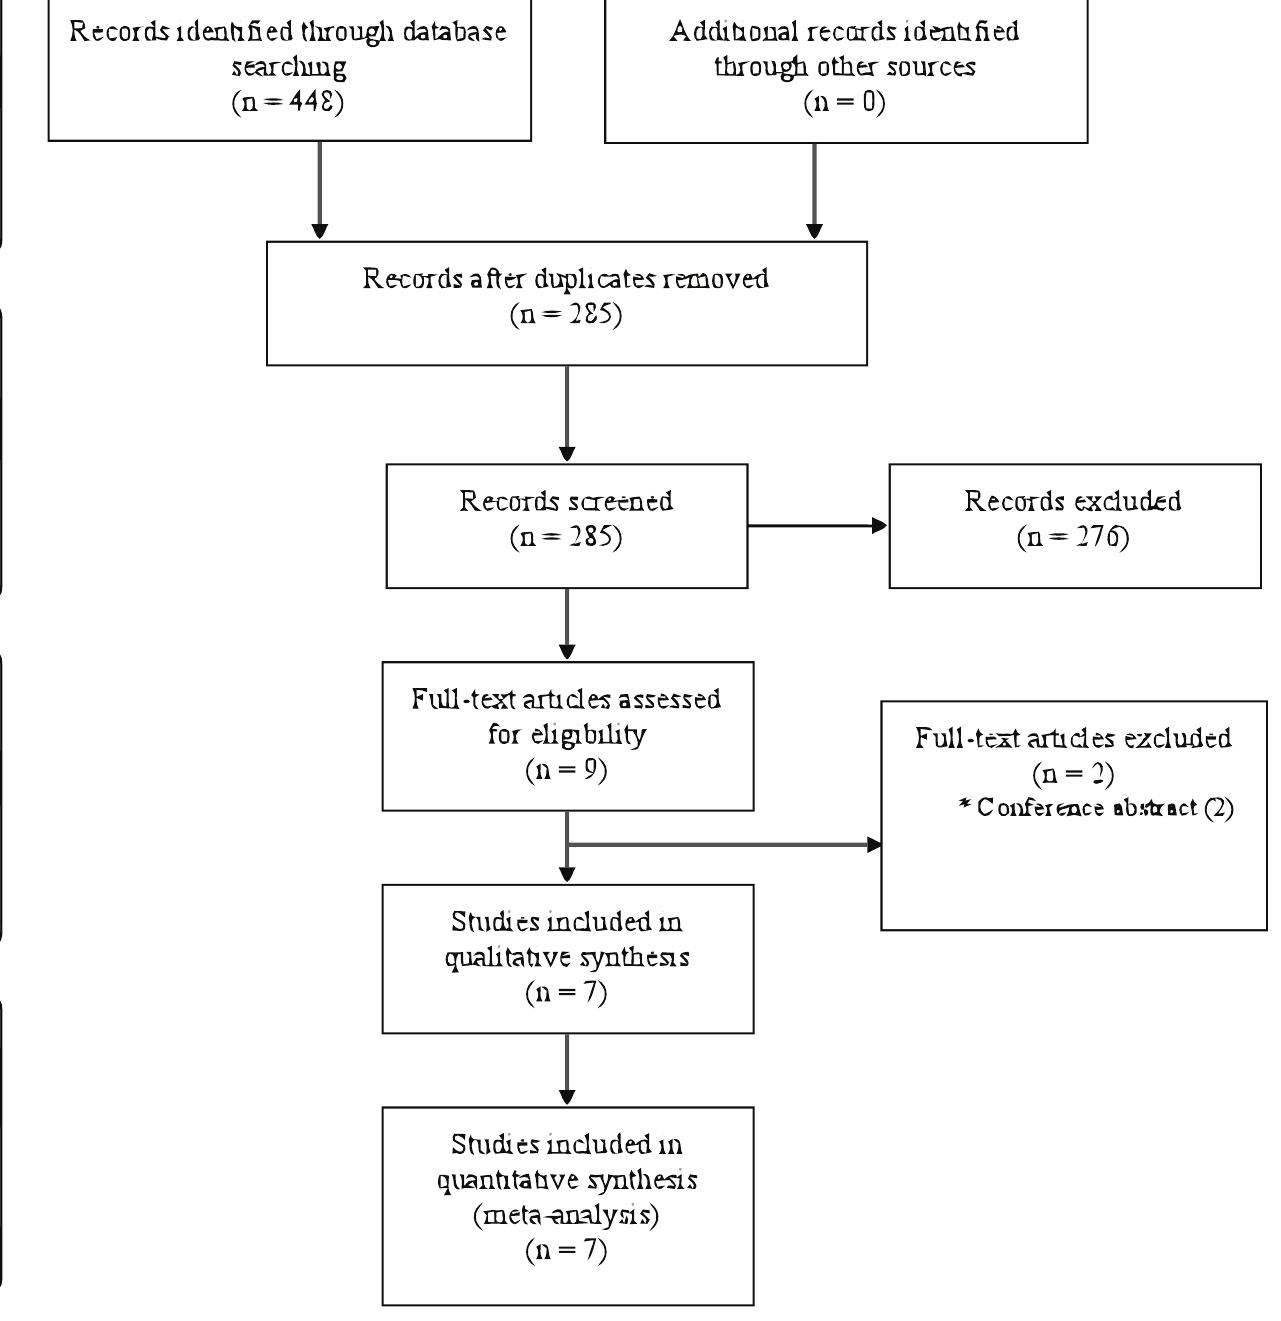
Fig 1. Flow diagram showing selection of studies for